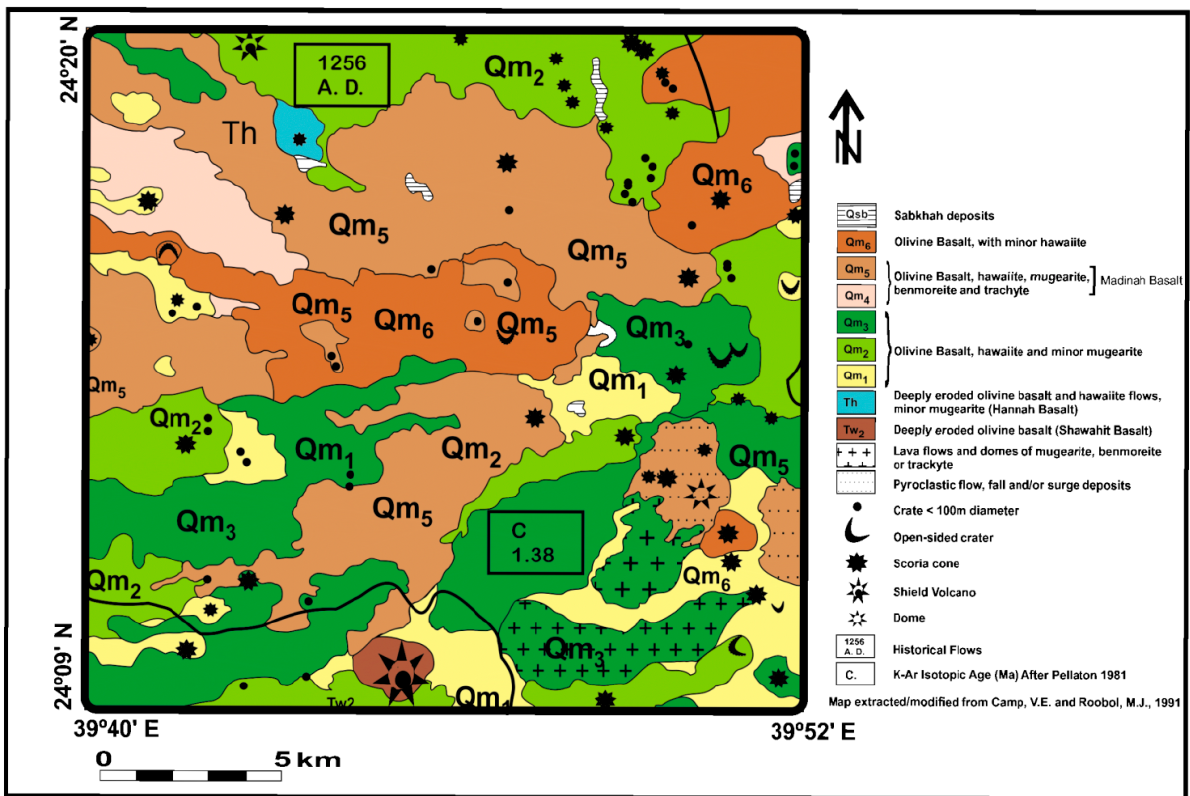
Figure 2. The geologic setting of the study area, part of the northern HRVF (modified after [55]). A variety of extruded basaltic rocks includes alkaline olivine basalts to hawaiite, as well as olivine transitional basalts. Benmoreite, mugerarite, and trachyte basically exist as tuff and dome cones, including lava flows [56,57]. The Harrat Al ‐ Madinah basalts were additionally segmented into lower and upper Al ‐ Madinah Al ‐ Munawwarah basalts [51,53,55]. Three flow units (Figure 2) constitute the upper Al ‐ Madinah Al ‐ Munawwarah basalts, namely Qm1 (~1.7–1.2 Ma), Qm2 (~1.2–0.9 Ma), and Qm3 (~0.9–0.6 Ma), whereas four flow units, Qm4 (~0.6–0.3 Ma), Qm5 (~0.3 Ma–4500 BP), and Qm6 (~4500–1500 BP), constitute the upper Al ‐ Madinah Al ‐ Munawwarahbasalts[28,51,53,55]. The Cenozoic volcanic rocks of the region lap onto and overlie the Proterozoic rocks, which are com ‐ prised of volcanic arc rocks and younger volcanic sedimentary successions. Previously, Berthier et al. [20] observed the indication of a structure running transverse to the general alignment of Harrat Khaybar, which acted as a trap for differentiated magmatic products since the Upper Pleistocene, therefore rendering the Harrat Rahat zone particularly fa ‐ vorable for the presence of an abnormal heat flow. They suggested the area for a high ‐ enthalpy geothermal source presence. A hot magmatic intrusion may exist at depths within this area, thereby implying a higher geothermal energy potential. Ambient noise cross ‐ correlation analysis was applied to the areas of the Harrat Rahat (Figure 3) to in ‐ vestigate the geothermal potentials and high heat flow [1]. This method uses the seismic noise background to infer the crustal velocity structure [58,59], and has recently been applied to geothermal areas and other regions with ahigh heat flow [1,60,61]. The area with a blue coloration in the inserted yellow square of Figure 4 denotes anarea of likely high subsurface heat flow based on the young volcanics as mapped from the surface ge ‐ ology [1].